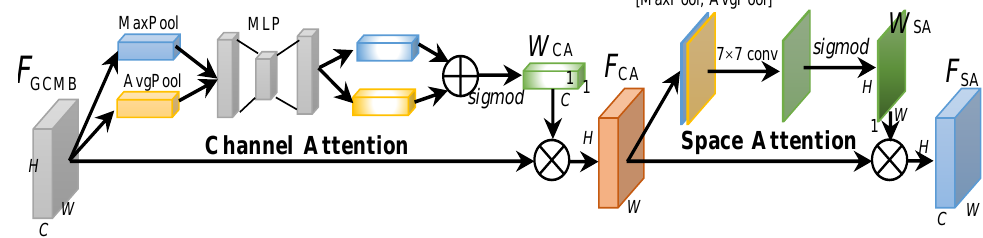
Figure 13. Implementation of the convolutional block attention module (CBAM) used in BAFE. For the channel attention, a max-pooling (MaxPool) is used to capture its local response, and an average-pooling (AvgPool) is used to capture its global response. A multi-layer perceptron (MLP) is used to refine them for better fusion between the local and global responses. Finally, the results are normalized by a sigmoid function to obtain W CA . The above is described by where σ denotes the sigmoid activation defined by 1/ ( 1 + e − x ) both operate on the channel dimension to achieve 2D feature maps. Their results are con-